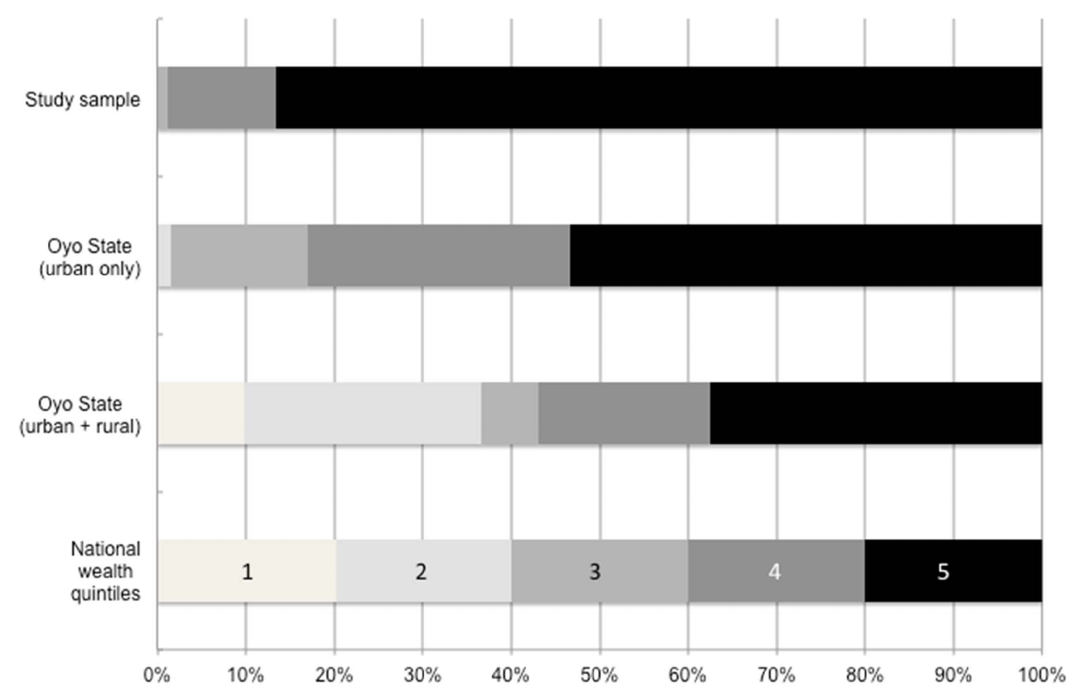
Figure 1. Wealth distribution of enrolled participants versus state and national populations. When comparing the wealth distribution between sampled individuals to that of the state and national populations captured by the 2010 MIS, those in the wealthiest quintile are disproportionately represented in the study sample. Based on the composite asset ownership measure, no individuals in the study sample were from the lowest two wealth quintiles of nation. Although the population of Oyo State, and particularly in urban areas, is also comprised of households that are much wealthier than the nation as a whole, the study sample’s wealth composition is even more concentrated among the wealthiest. Source: 2010 Nigeria Malaria Indicators Survey.